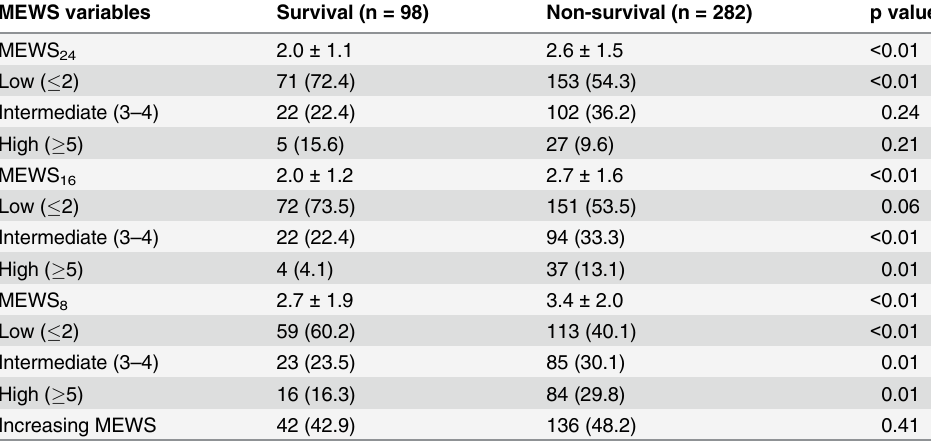
Table 6. Modified Early Warning Score (MEWS) and Hospital